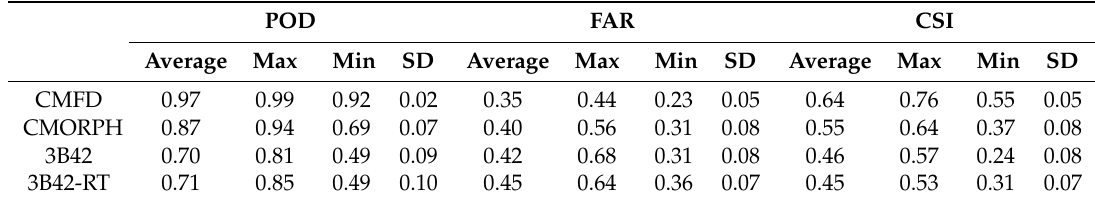
Figure 3. The spatial distributions of CC from ( a ) CMFD, ( b ) CMORPH, ( c ) 3B42 calibrated, ( d ) 3B42- RT, and RMSD (mm) from ( e ) CMFD, ( f ) CMORPH, ( g ) 3B42 calibrated, ( h ) 3B42-RT at each station for the four precipitation products evaluated in this study. Table 4. Categorical metrics for detection of daily precipitation at 36 stations in Beijing using four satellite-derived precipitation products.